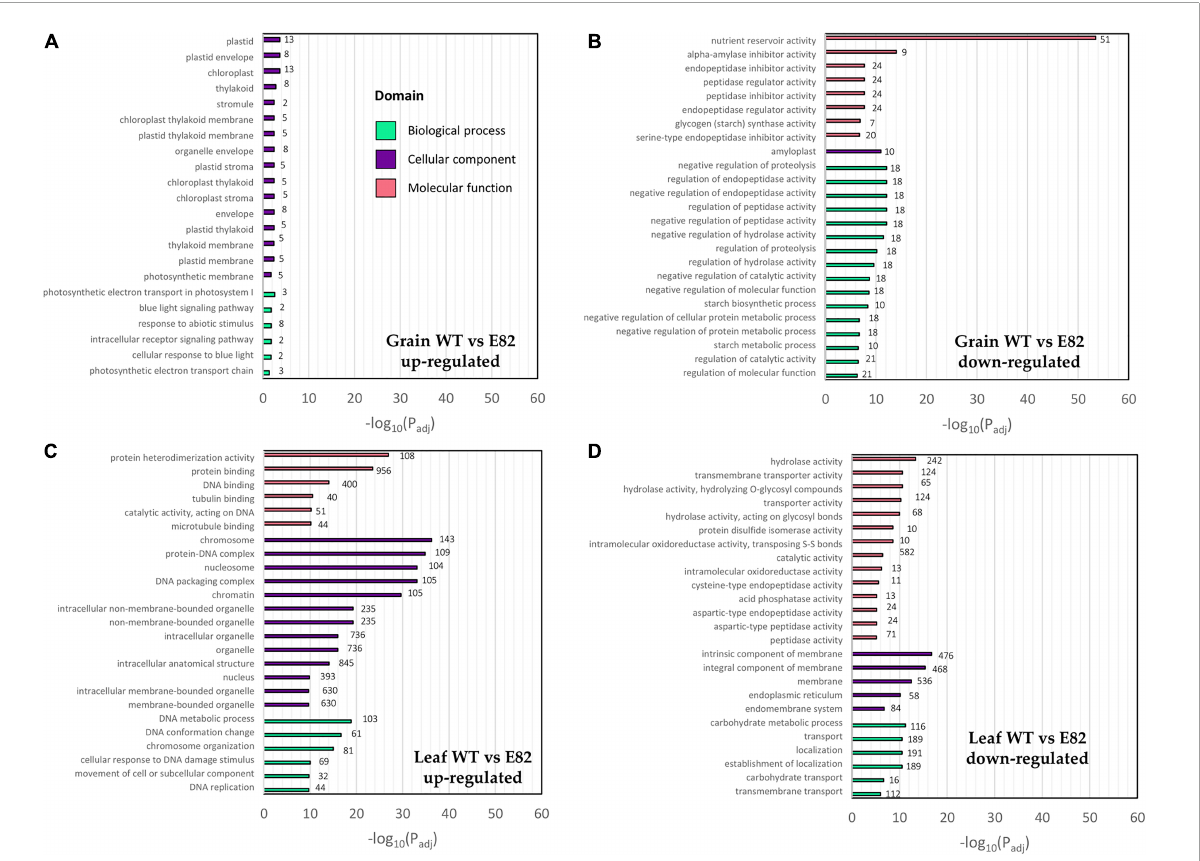
FIGURE1 Gene Ontology (GO) enrichment analysis of up- and down-regulated genes in the wild type (WT) vs. E82 comparison in grain (A,B) and leaf (C,D) tissues. The top GOs are represented. Values on the bars represent the number of differentially expressed (DE) genes annotated with each GO term. P -value was adjusted with the Benjamini-Hochberg